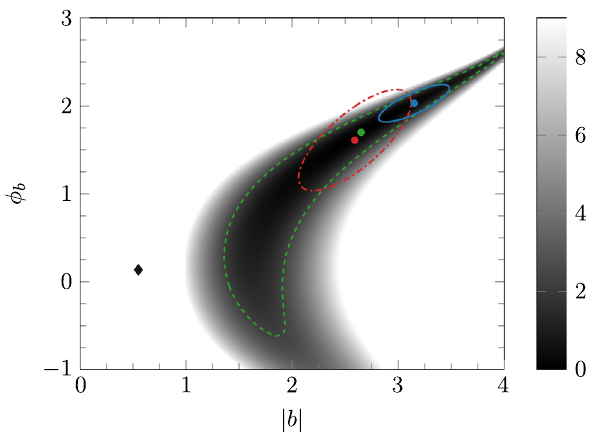
Fig. 3 Comparison of different determinations of the free parameters ) for the “2 par.” case (similar results are obtained for “3 par.”). ( | b | ,φ b The blue solid (red dashed) line represents our two-parameter ( | b | ,φ b ) 1 σ (68% CL) error ellipse for the low (high) φ ωπ 0 ( 0 ) solution (global fits, χ 2 , cf. Eq. (3.3)) described in Sect. 3.2, with parameters given in Table 2. Errors are estimated with MC resampling, as explained in the text and in Appendix A. The background color represents the value of the function χ 2 [cf. Eq. (3.1a)] as a function of | b | and φ b , thus DP corresponding to the fit described in Sect. 3.1 [cf. Eq. (3.2a)]. The (cid:9) 2 . 3 contour (at the minimum, green dashed line represents the χ 2 DP = 0), that corresponds to the two-parameter 1 σ region. Lastly, the χ 2 DP black diamond represents the value b sum , Eq. (2.20)